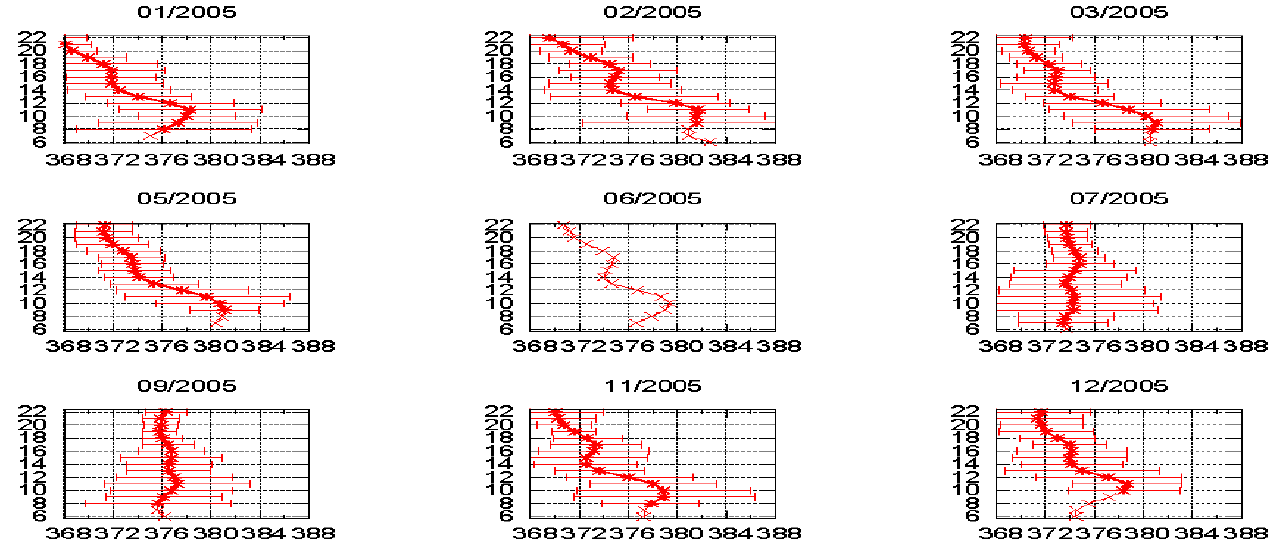
Fig. A2. Same as Fig. A1 for